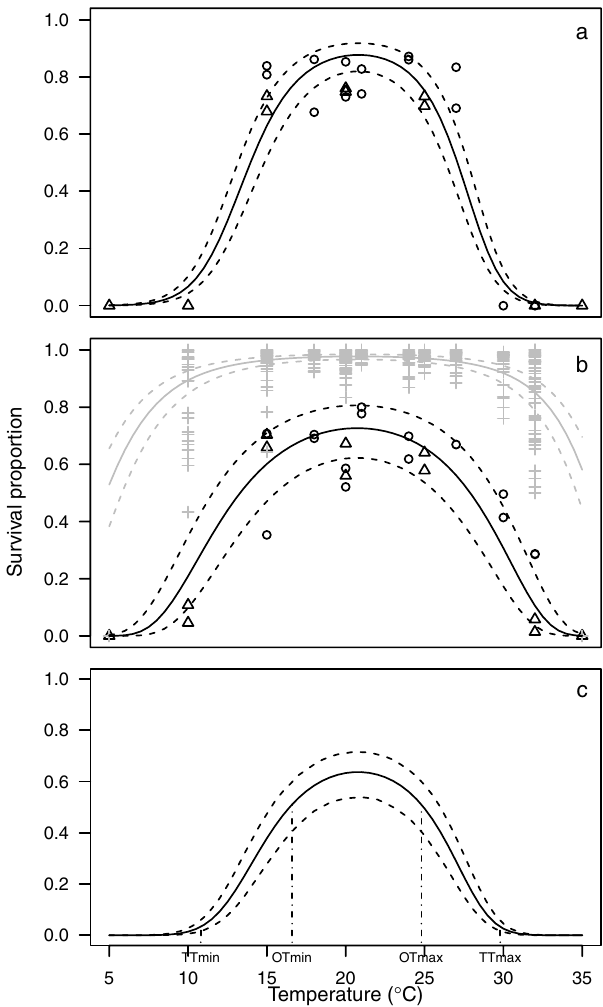
Fig. 3. (a) Embryo survival with respect to temperature, (b) larval survival with respect to temperature and (c) survival from hatching to 14 dph with respect to temperature. Open circles and triangles rep- resent the 2008 and 2009 experimental data respectively, grey lines represent daily survival, and black lines indicate cumulative survival. The solid and dashed lines show the expected survival and the 95% confidence intervals, respectively. TT min and TT max define the toler- ance range (i.e., at least 5% survival), and OT min and OT max define the optimal range (i.e., at least 80%